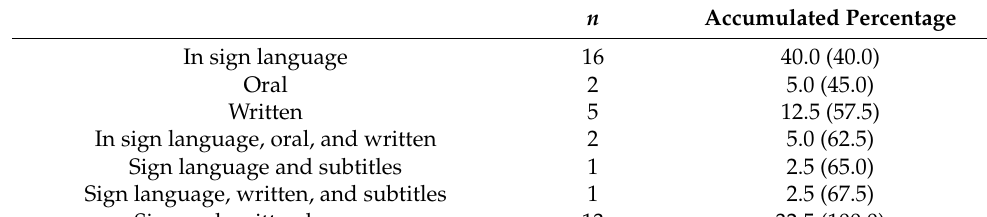
Table 4. Type of information received during the time of the pandemic.